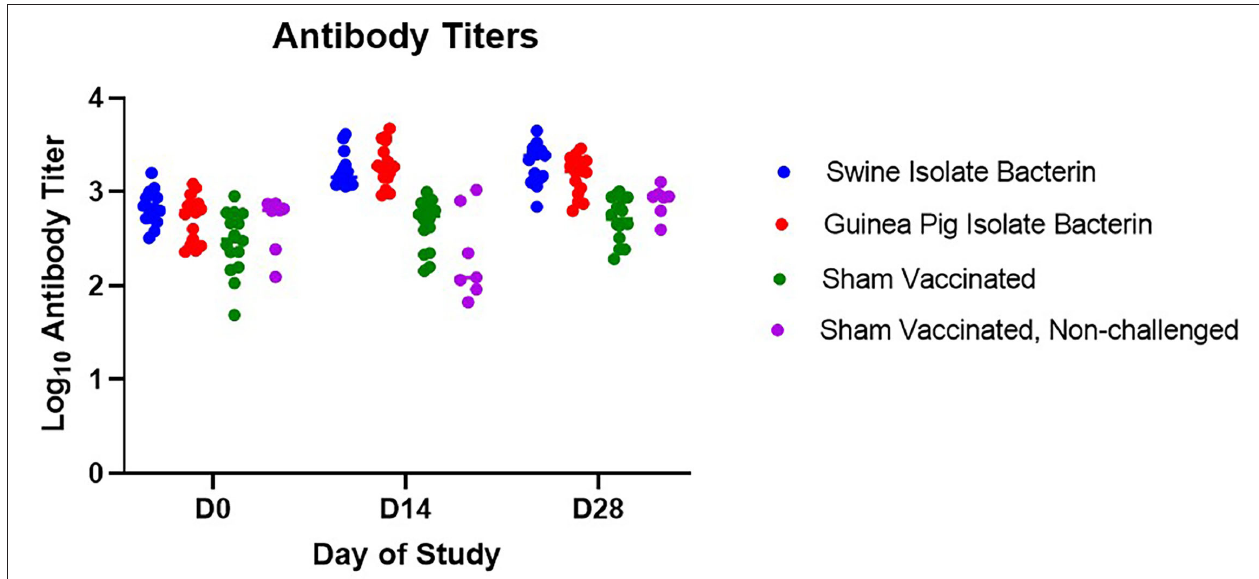
FIGURE 1 | Serum antibody response to vaccination. Antibody titers for swine isolate and guinea pig isolate bacterin vaccine groups were higher than sham vaccinated animals following vaccination (days 14 and 28, p < 0.0001). No anamnestic response was seen following boost vaccination in either bacterin vaccine group (swine isolate, p = 0.6560; guinea pig isolate, p =